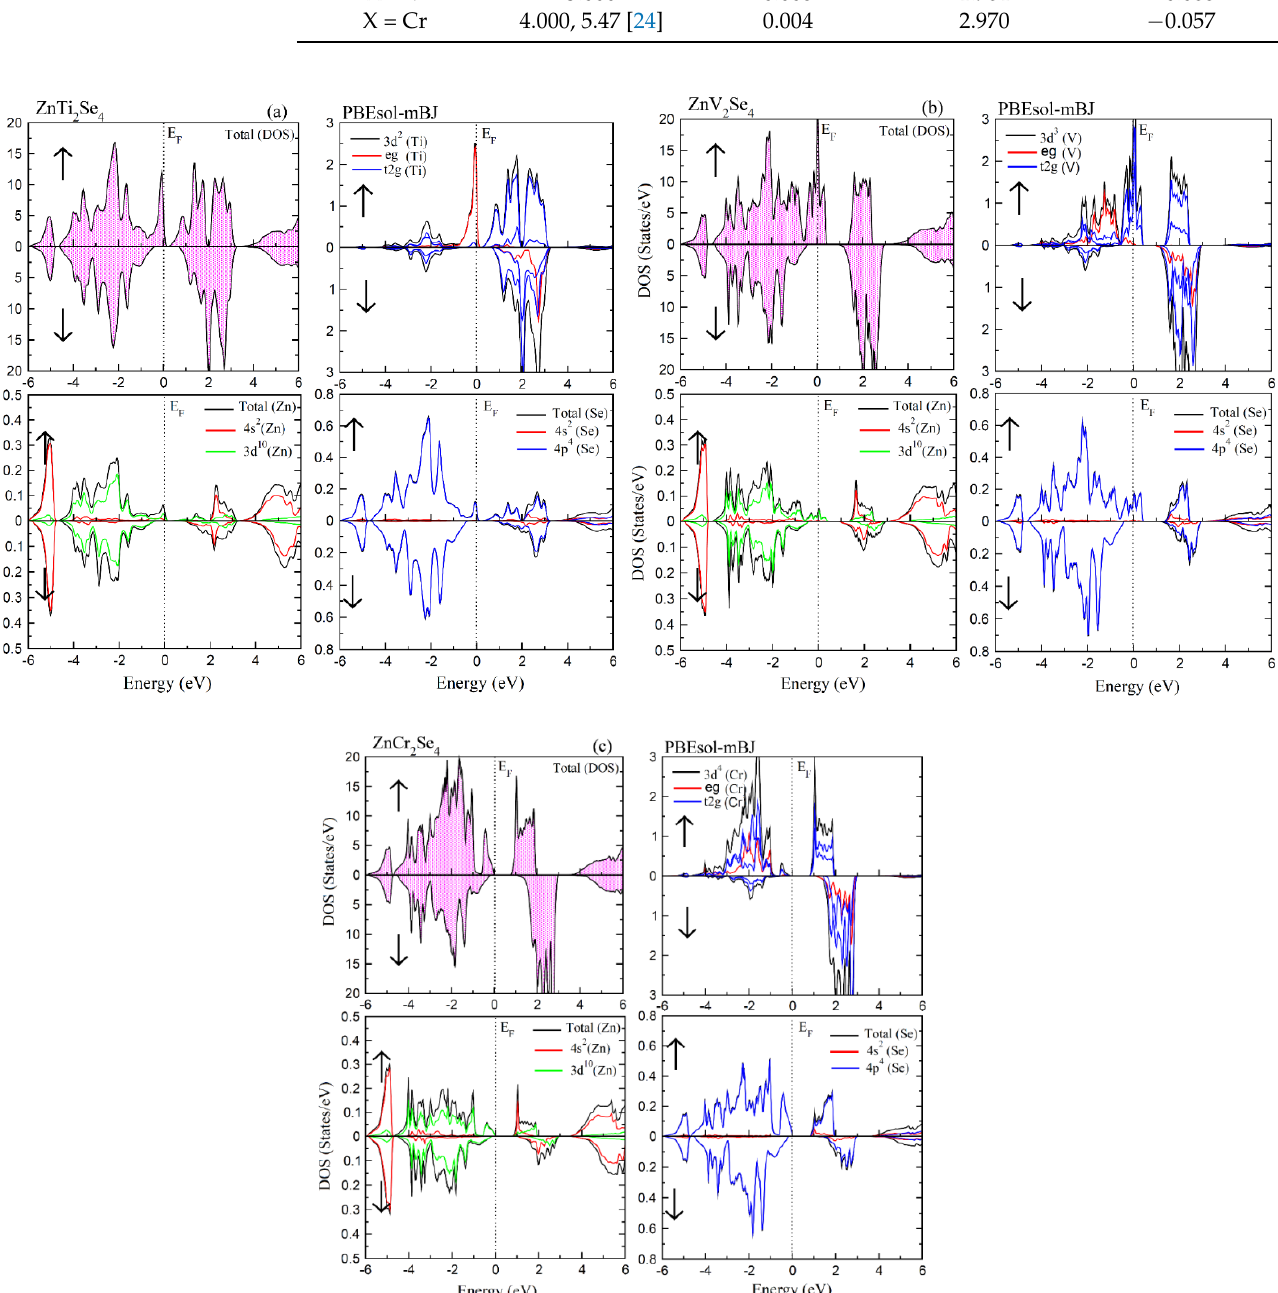
Figure 4. ( a ) The total DOS of ZnTi 2 Se 4 and PDOS of Zn, Ti, S formed by PBEsol-mBJ; ( b ) the total DOS of ZnV 2 Se 4 and PDOS of Zn, V, S formed by PBEsol-mBJ; And ( c ) the total DOS of ZnCr 2 Se 4 and PDOS of Zn, Cr, S formed by PBEsol-mB. Table 2. The computed (crystal field energy) Δ E crystal , interchange energy Δ x ( d ), pd -exchange energy Δ x ( pd ) and interchange constants ( N o α and N o β ) of ZnX 2 Se 4 (X = Ti, V, Cr). Composition